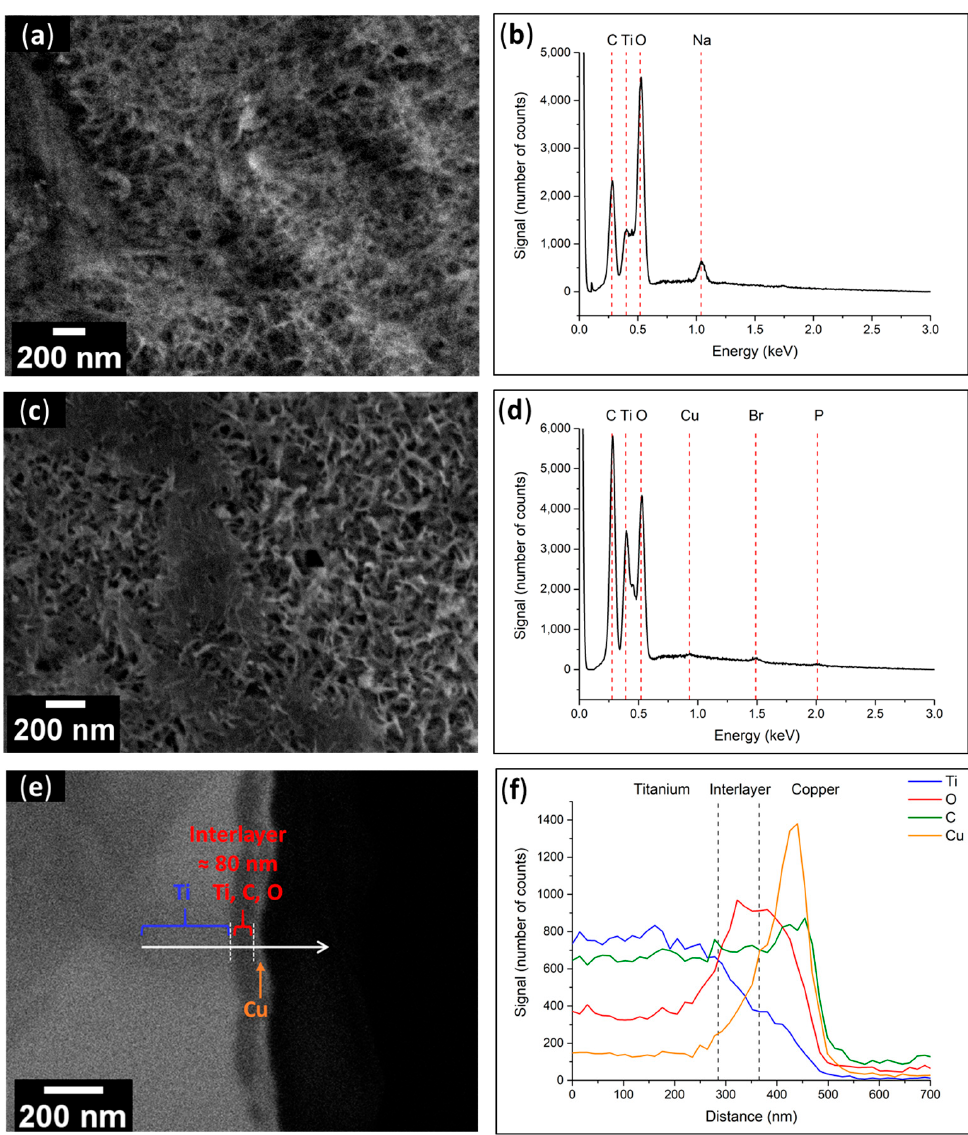
Figure 9. ( a ) SEM top view image and ( b ) EDX spectrum of the Ti–OH surface; ( c ) SEM top view image and ( d ) EDX spectrum of the Ti–PCI surface; ( e ) SEM cross-sectional view and ( f ) Linear analysis of the Ti–PCI interface.